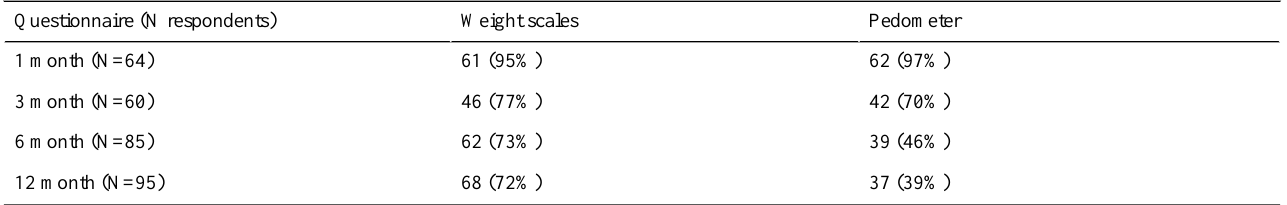
Table 3. Users of weight scales and pedometer according to usefulness questionnaires.